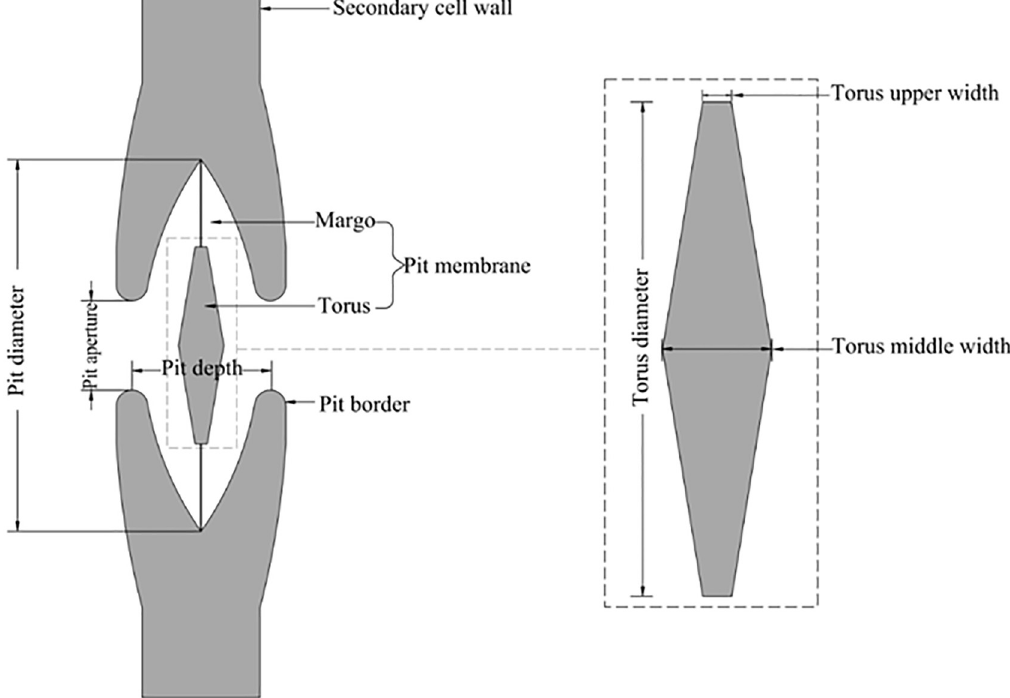
Fig 1. Schematic diagram of torus-margo bordered pit